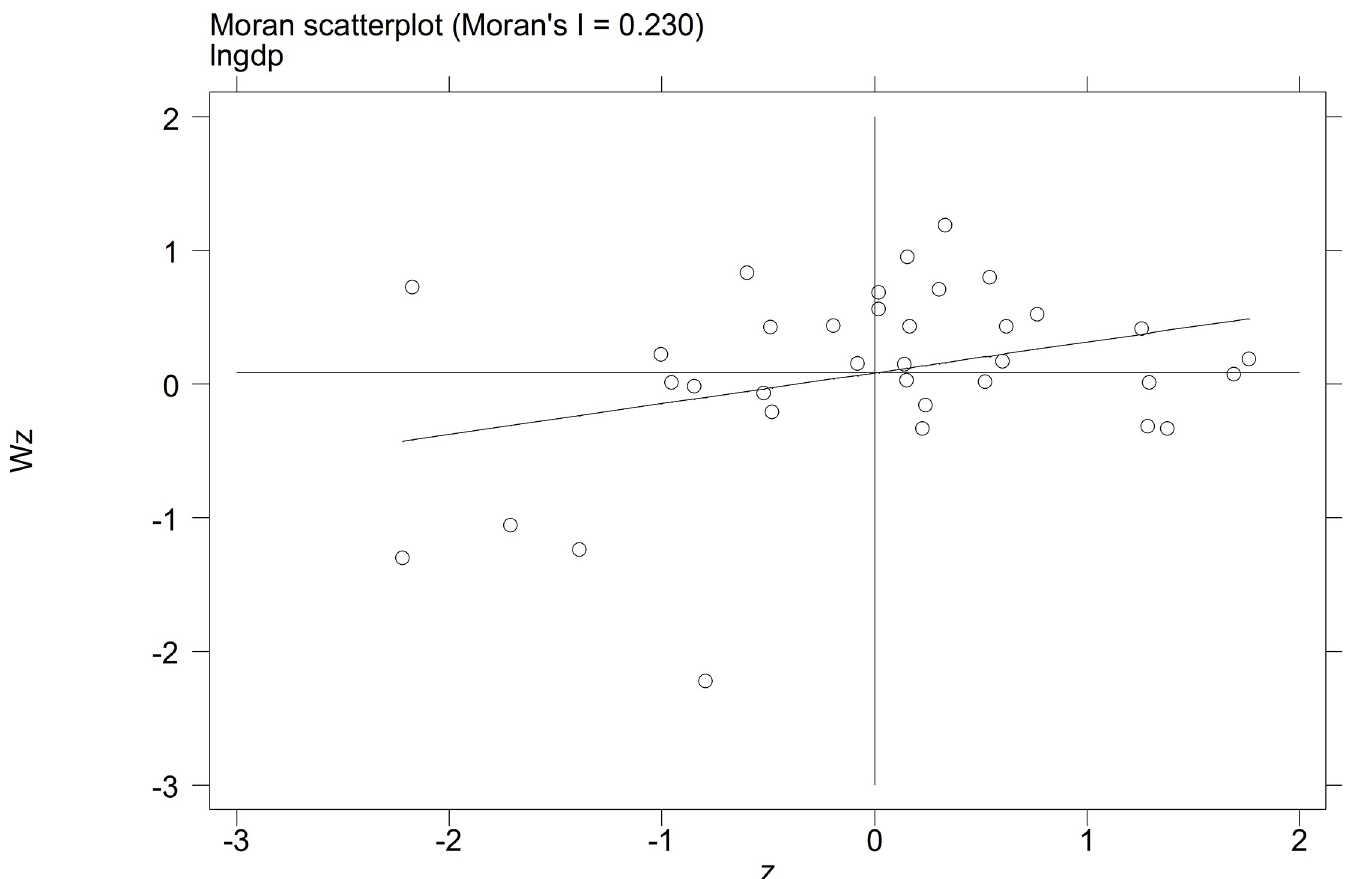
Fig 2. Scatterplot of Moran’s I for GDP in Dec.